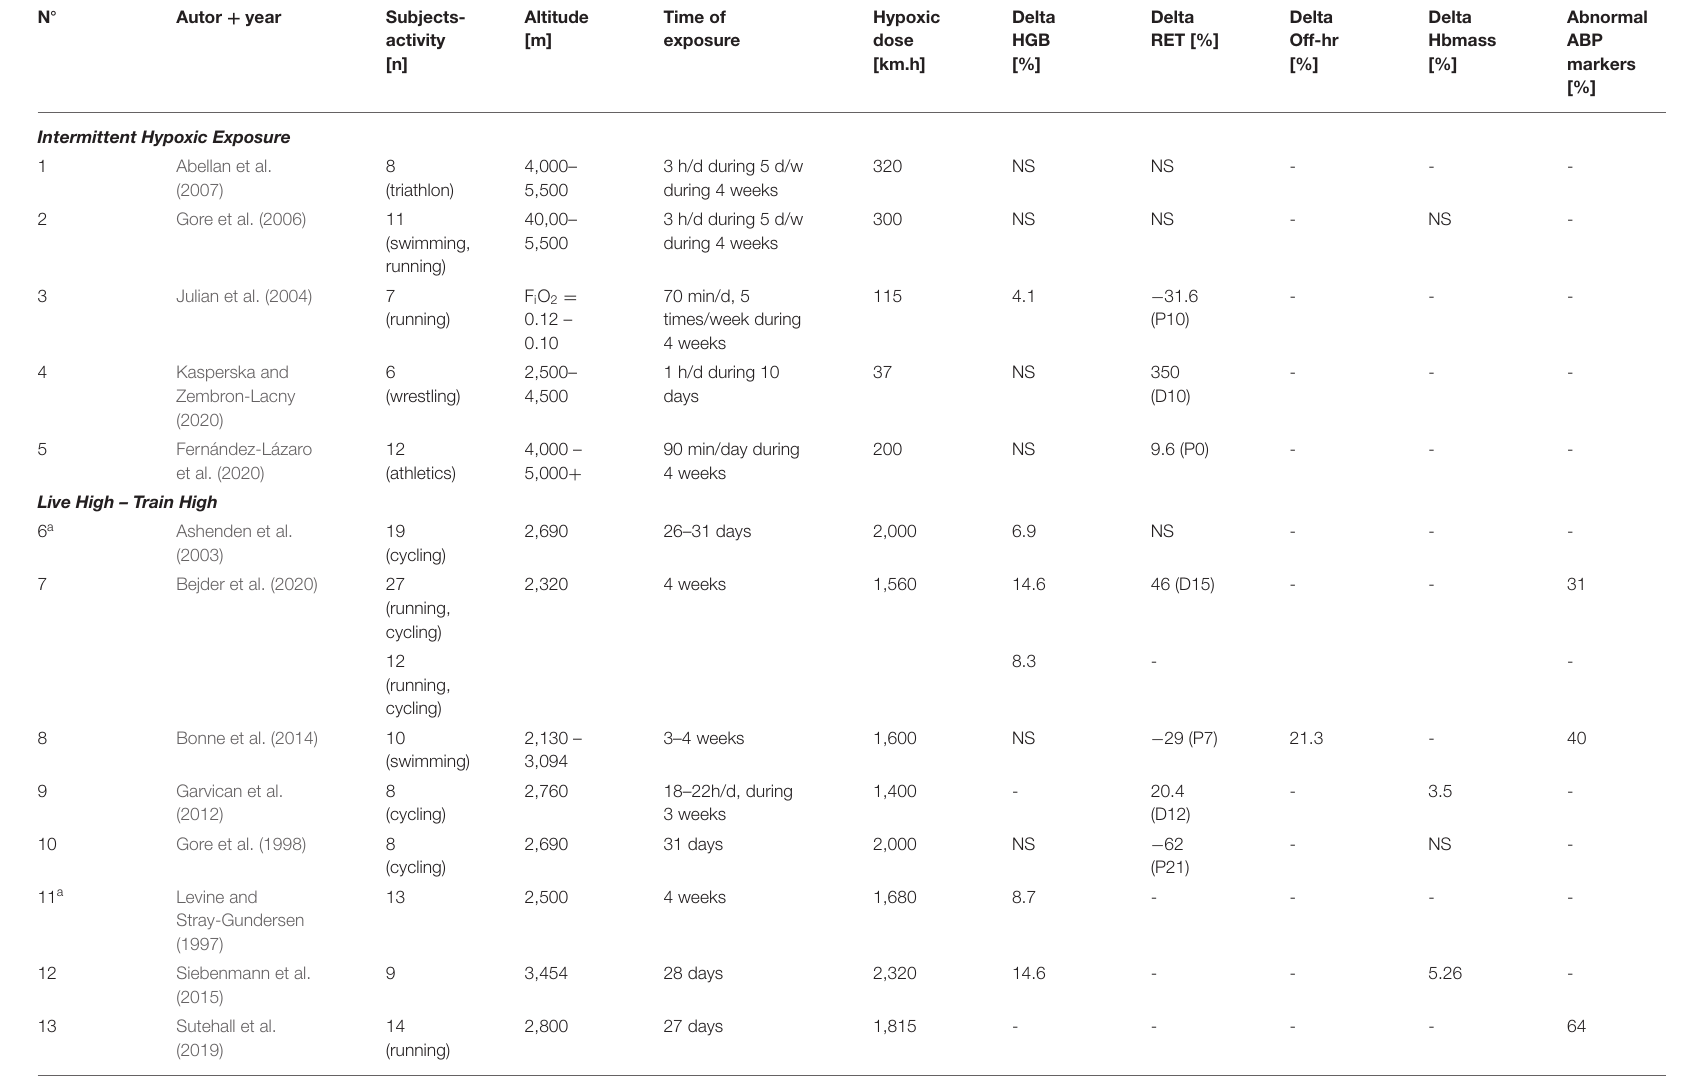
TABLE 1 | Summary of the main parameters collected in the 26 altitude studies of the literature